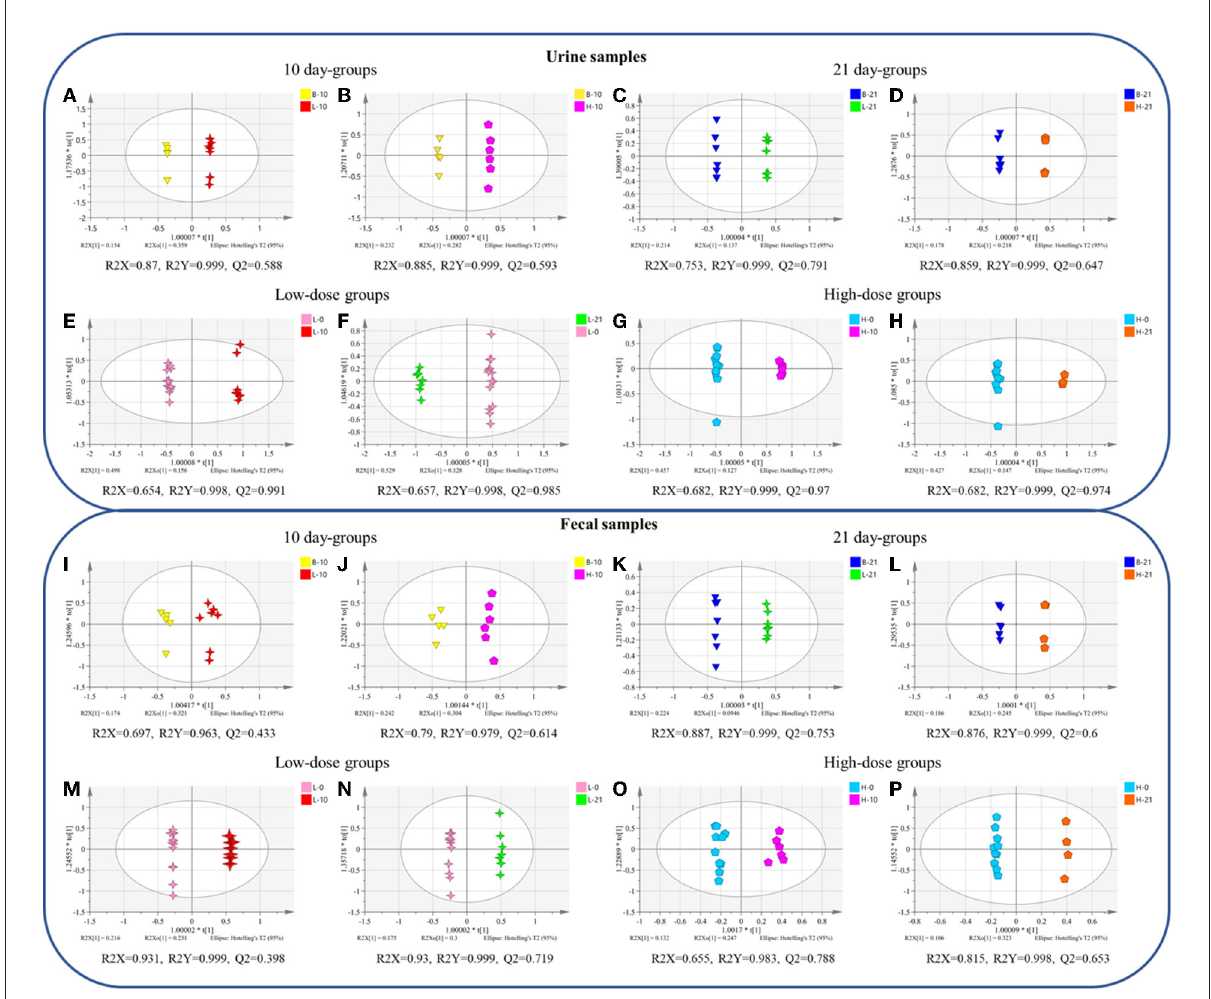
FIGURE2 The orthogonal partial least squares-discriminant analysis (OPLS-DA) between different groups of urine (A–H) and fecal (I–P) samples. (A,I) blank group vs. low-dose group on the 10th day; (B,J) blank group vs. high-dose group on the 10th day; (C,K) blank group vs. low-dose group on the 21st day; (D,L) blank group vs. high-dose group on the 21st day; (E,M) 0-day vs. 10-day of low-dose groups; (F,N) 0-day vs. 21-day of low-dose groups; (G,O) 0-day vs. 10-day of high-dose groups; (H,P) 0-day vs. 21-day of high-dose groups. ( n = 4–8).